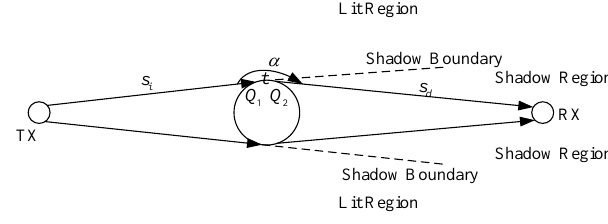
Figure 3. Physical model of cylindrical surface diffraction.